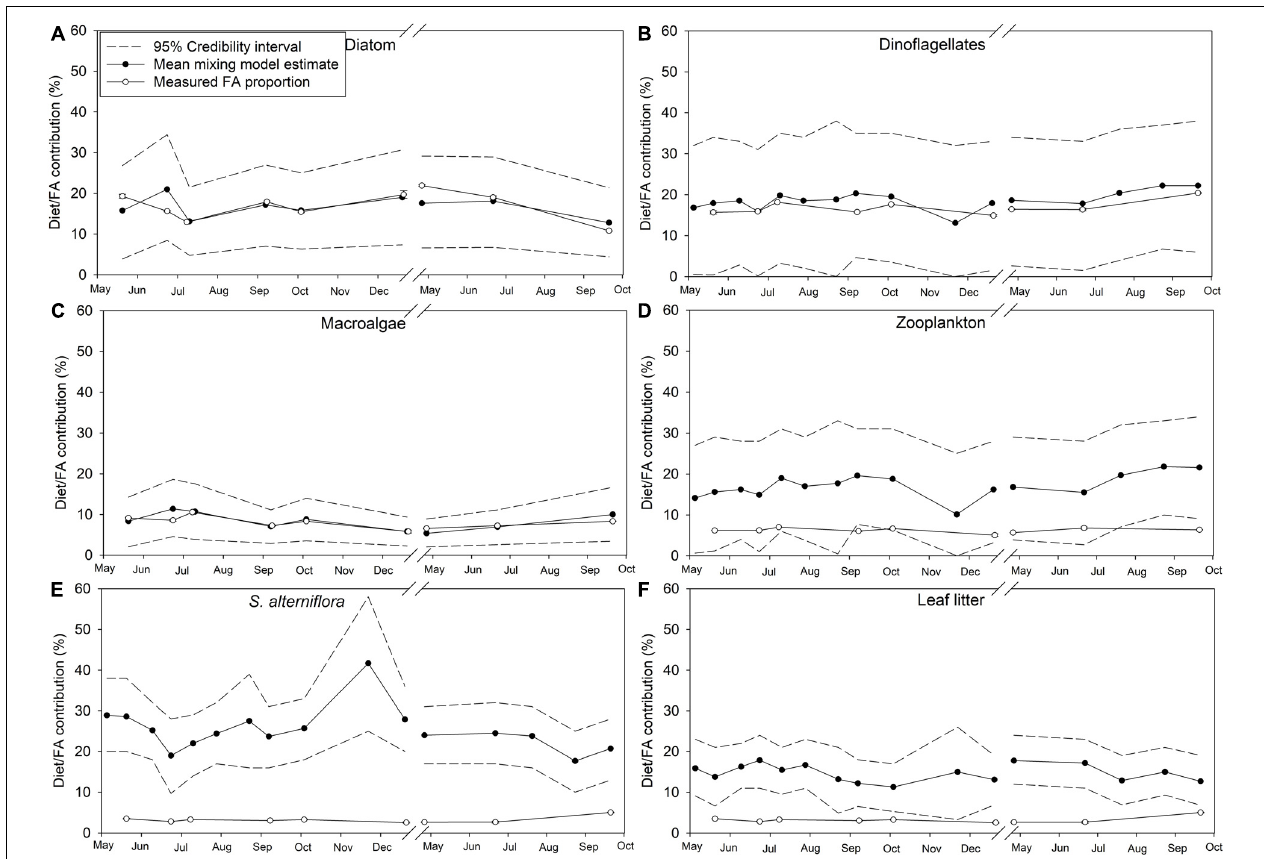
FIGURE 10 | Endmember diet contribution (%) to Mytilus edulis in Saco Bay, ME, United States, throughout 2016 and 2017. Values shown are the mean diet contribution (%) estimated from the dual isotope ( δ 13 C and δ 15 N) Bayesian mixing model along with accompanying credibility interval (95%) and the proportion (% total FAs) of endmember biomarker FAs measured in M. edulis . Endmembers: (A) Diatoms (16:1 ω 7, 16:4 ω 1, and 20:5 ω 3), (B) Dinoflagellates (22:6 ω 3), (C) Macroalgae (18:1 ω 9, 18:3 ω 6, 20:2 ω 6, 20:4 ω 3, and 20:4 ω 6), (D) Zooplankton (20:1 and 21:1), (E) Spartina alterniflora (18:2 ω 6 and 18:3 ω 3), and (F) leaf